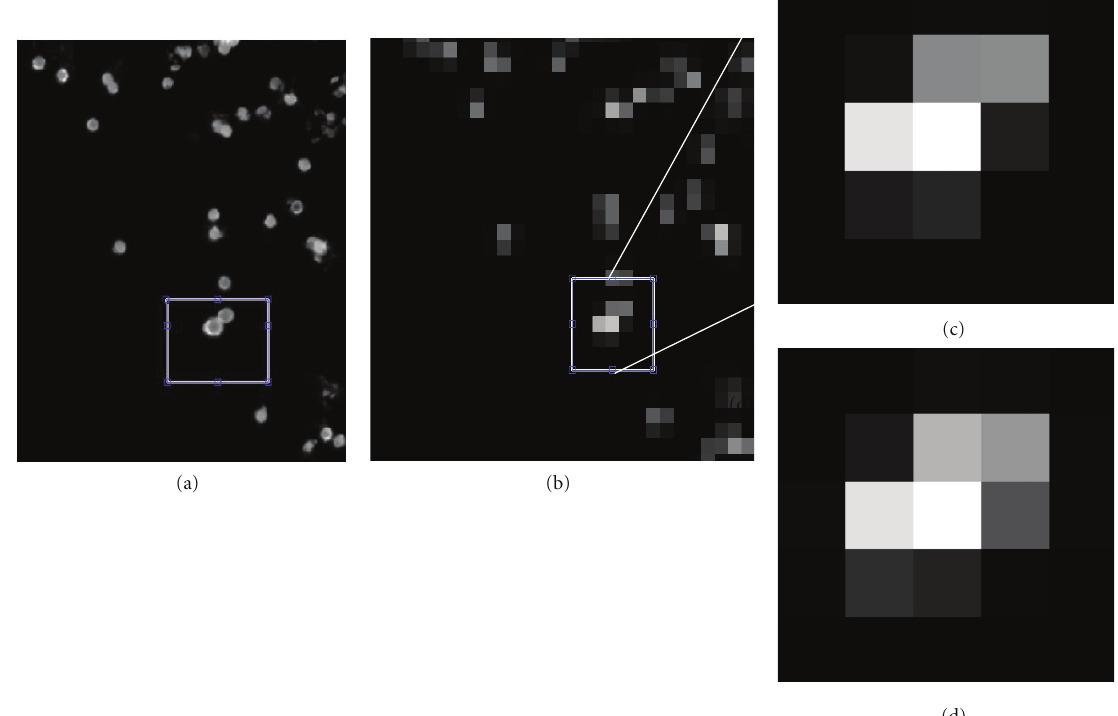
Figure 3: High-resolution images of microspheres are used to validate results of model-based processing on working-resolution images. High-resolution (63x) (a) and working-resolution (7x) images (b, c) of green fluorescent microspheres were obtained. There is a two- microsphere cluster in (a), which is visually ambiguous at the working resolution. The algorithm’s result for a two-cell cluster in (d) visually matches the image in (c). Other numbers of microspheres resulted in a much poorer fit to data. Note that ≈ 9 × 9 pixels in the high- resolution image correspond to 1 pixel in the low-resolution image and that the “grid” is not exactly maintained; that is, the 2D region in (a) only approximates regions in high-resolution images. The lower left microsphere in (a) is brighter than the other probably because it is closer to the